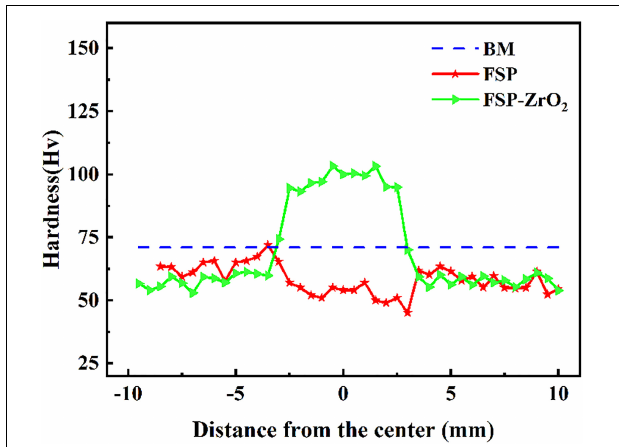
FIGURE 8 | The microhardness distribution of BM, FSP and FSP-ZrO2 samples.